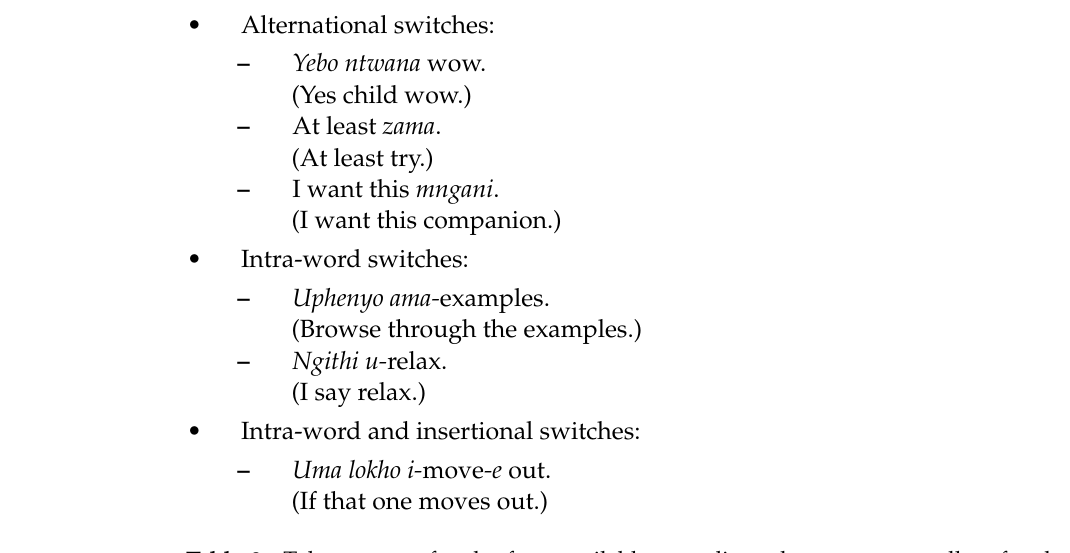
Table 3. Token counts for the four available monolingual corpora, as well as for the synthetic code-switched corpus, which contains both English and the respective Bantu language. English